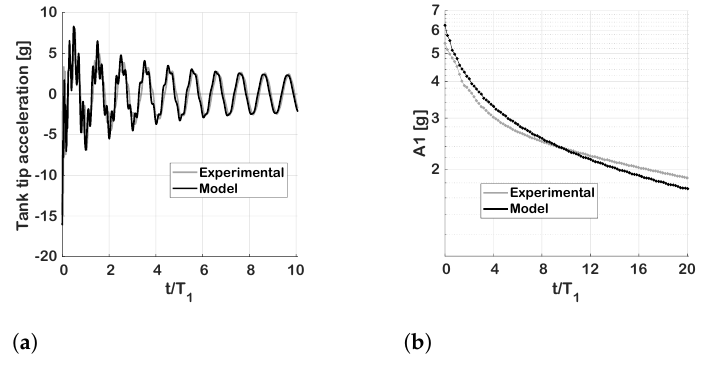
Figure 6. Tank tip acceleration comparison between experiment and model. Deflection at the tip of the wing is 2.7% of the semispan: ( a ) acceleration time series for the dry case; ( b ) amplitude of the first bending component versus